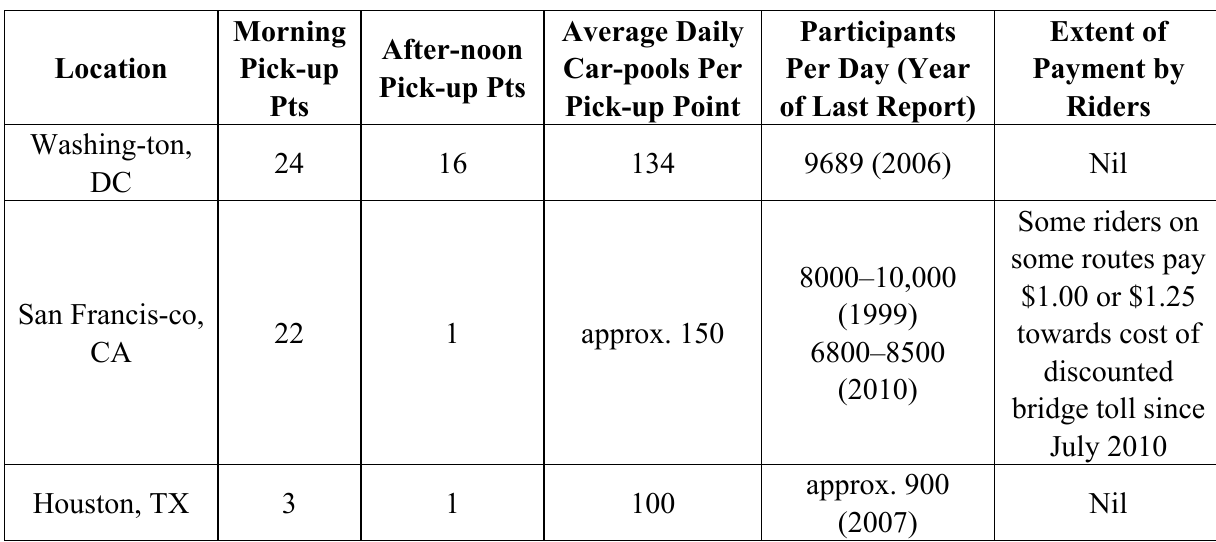
Table 1. Casual Carpooling Locations and Characteristics